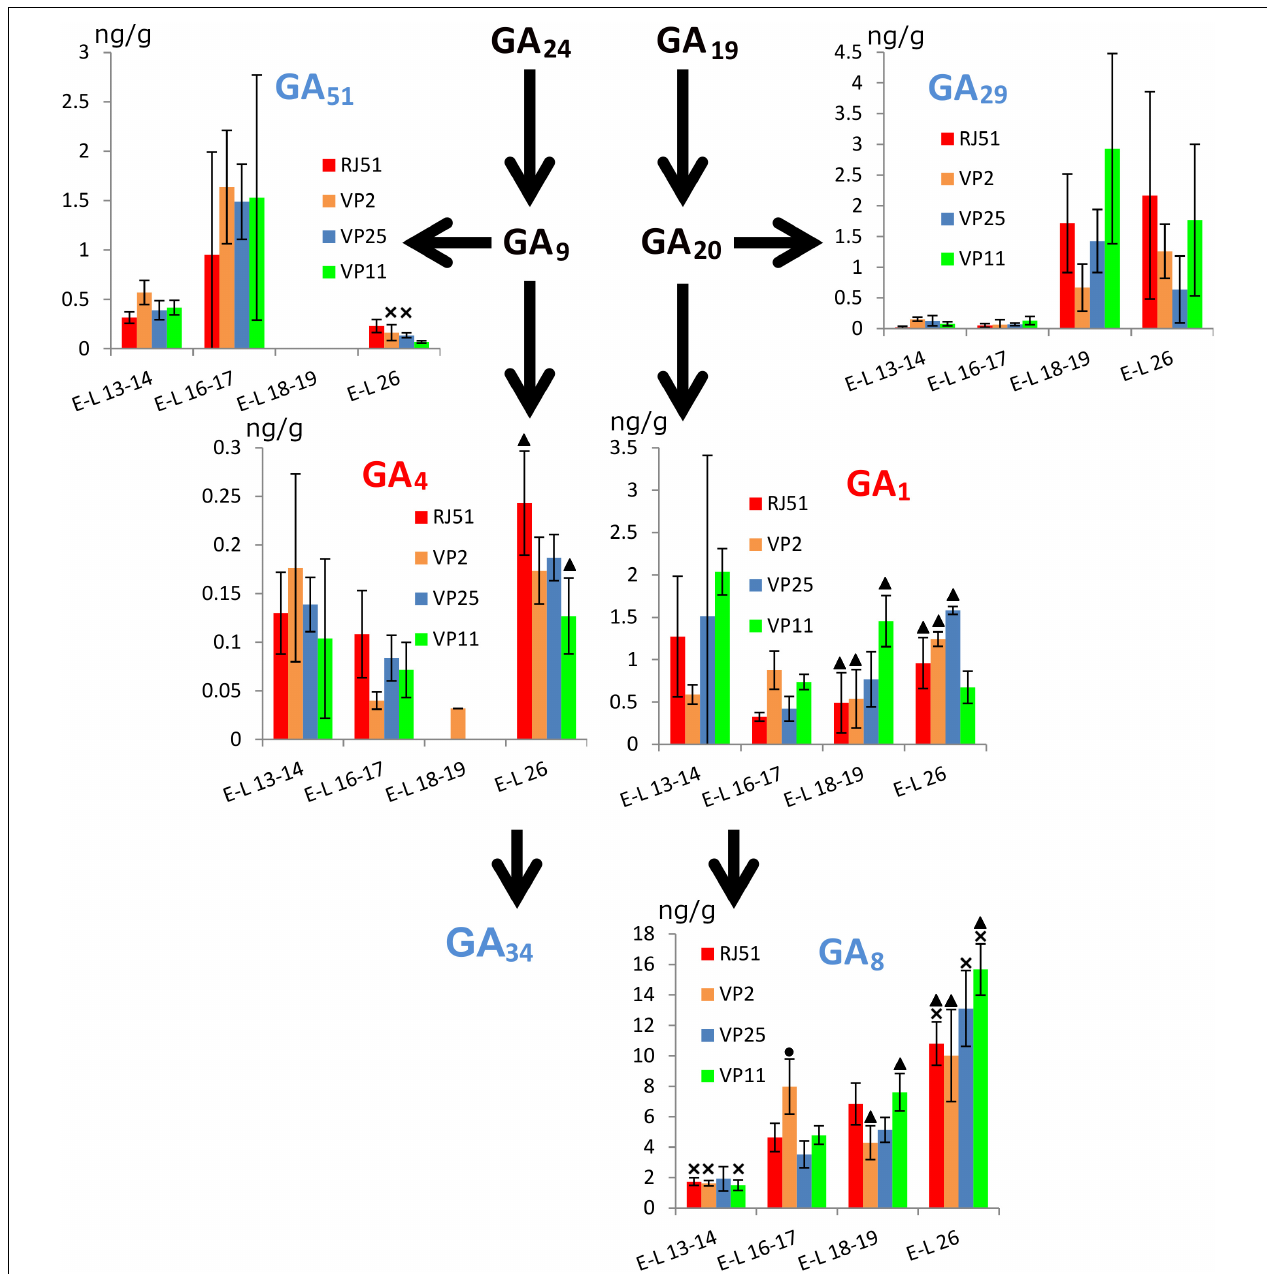
FIGURE 3 | Abundance (ng/g fresh weight) of the main gibberellins within the grapevine flower development. Red, active gibberellins; blue, inactive gibberellins; black, intermediate. Cross, significantly different against the other three stages; circle, significantly different against the other three clones; and triangle, significant differences between two clones with different